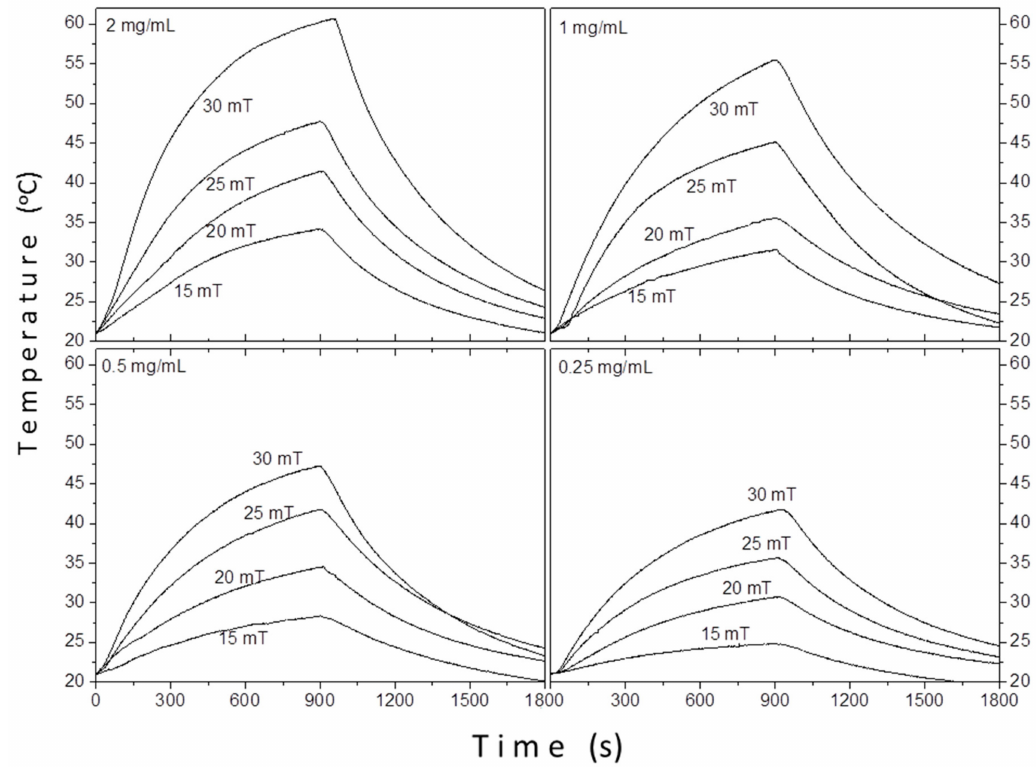
Figure 9. The temperature versus time curves of sample TD1. The temperature increases as long as the magnetic field is applied (900